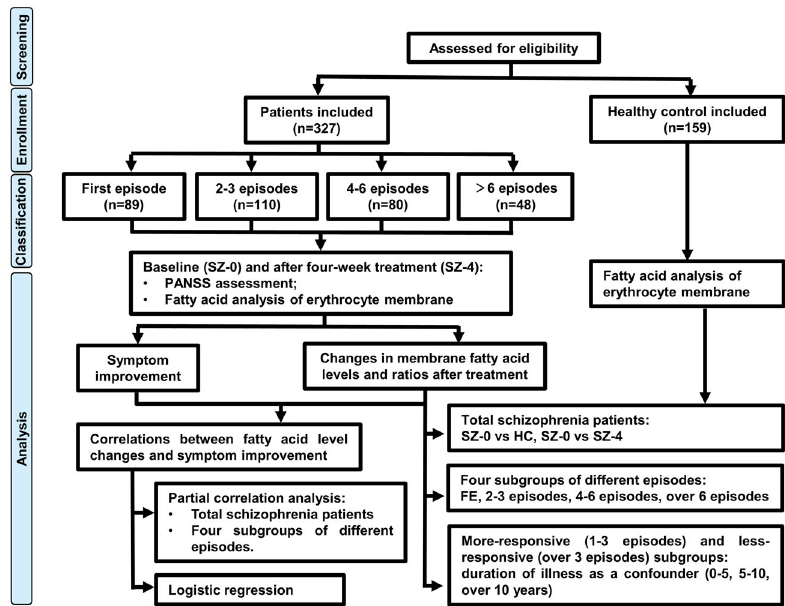
Fig. 5 Flowchart of the research. Through eligibility assessment, 327 schizophrenia patients and 159 healthy controls were recruited. The recruited patients were divided into four subgroups according to episodes: fi rst episode (FE), 2 – 3 episodes, 4 – 6 episodes, and over 6 episodes. We measured the concentrations of ten fatty acids in the erythrocyte membrane and performed PANSS assessment at baseline (SZ-0) and after four weeks of treatment (SZ-4). Total and subgroup analyses were conducted to identify differential biomarkers between schizophrenia patients and healthy controls. Correlations between fatty acid level changes and symptom improvement were analyzed by partial correlation analysis and logistic regression, to explore potential biomarkers indicative of treatment